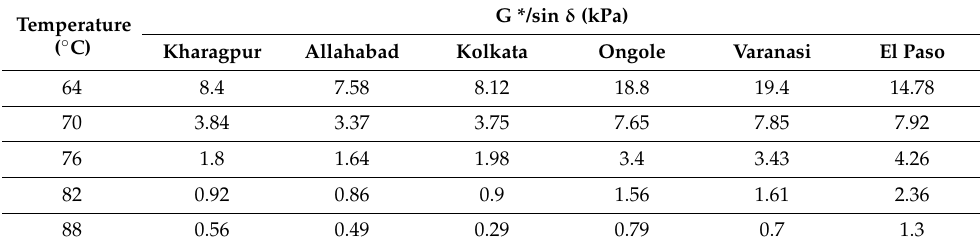
Table 6. G */sin δ for RAP Binders.